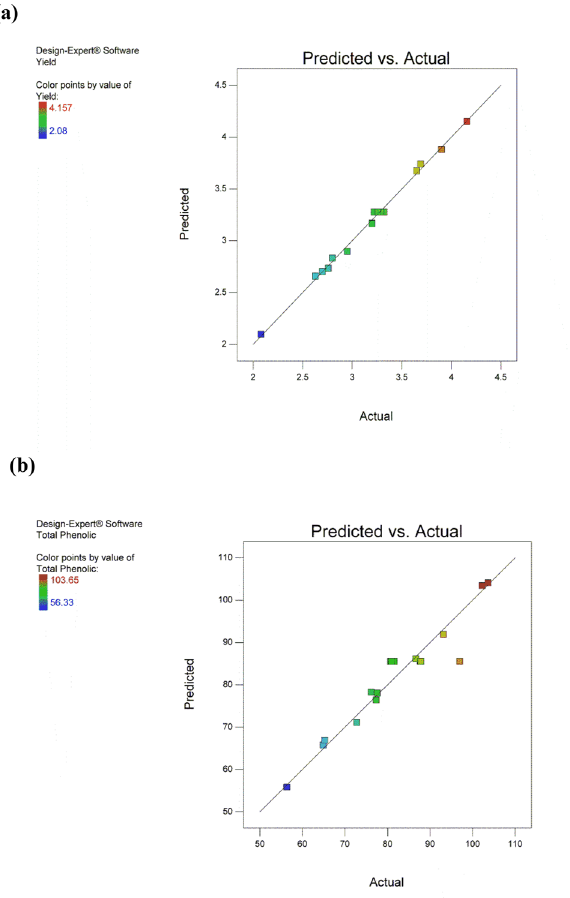
Figure 5. Diagnostic plots for BBD model adequacy. ( a ) Yield ( b ) Phenolic